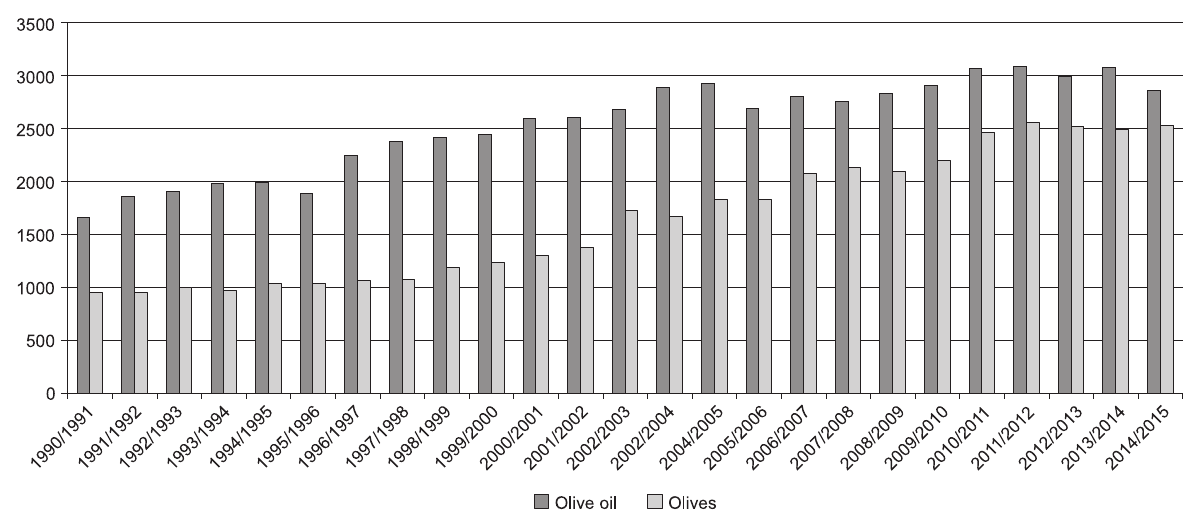
Fig. 3. Evolution of the global consumption of olives and olive oil, 1990–2015. Source: International Olive Council (last accessed on 25/07/2016) (http://www.internationaloliveoil.org/estaticos/